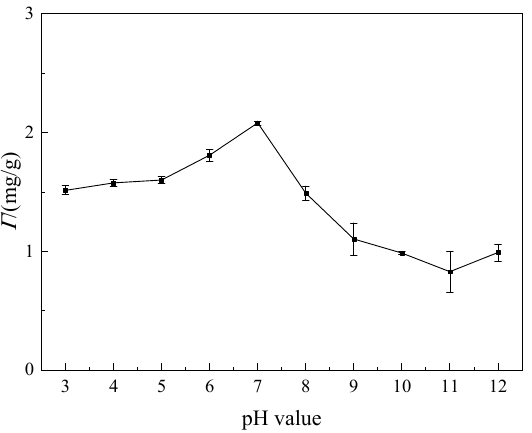
Figure 12. Effect of pH value on the adsorption of welan gum on montmorillonite.